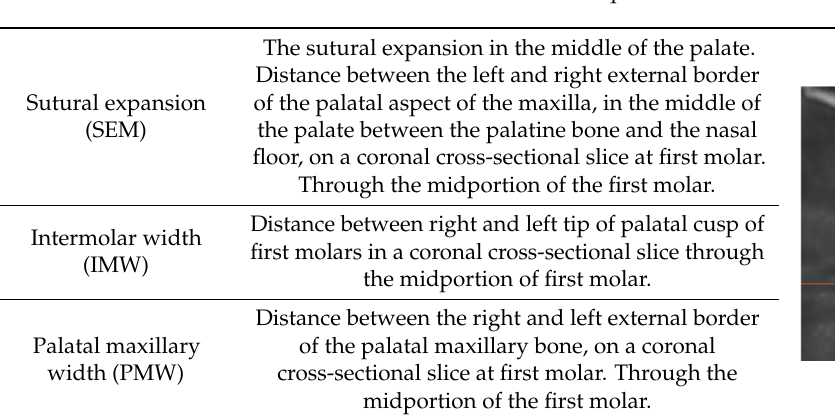
Table 4. Radiographic CBCT measurements to quantify skeletal, dentoalveolar and dental expansion. Sutural expansion, intermolar width and palatal maxillary width (SEM, IMW and PMW) were measured at first molar and quantified on the same coronal cross-sectional